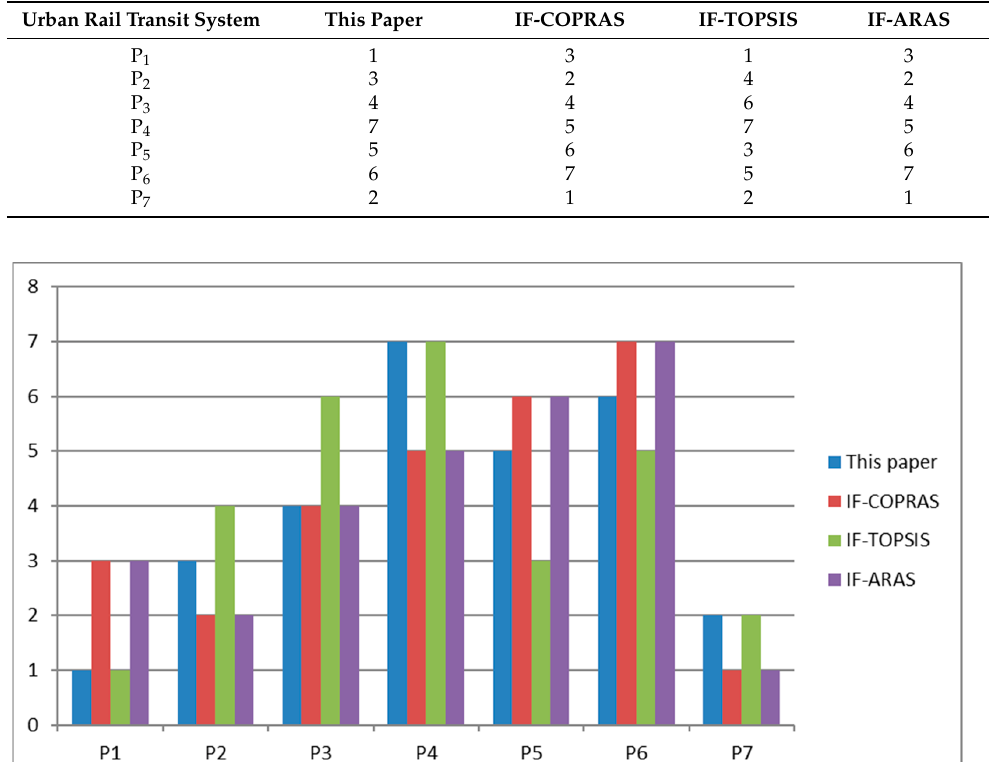
Figure 4. The ranking results based on different evaluation methods.